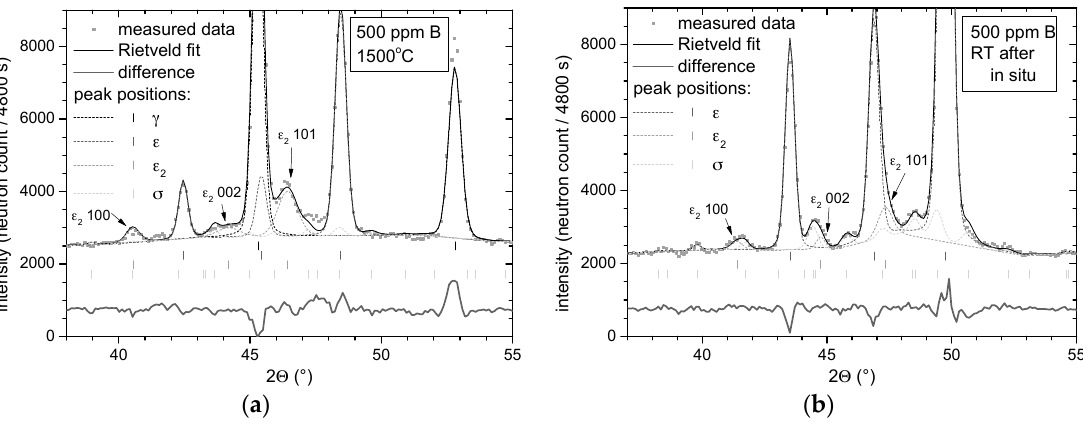
Figure 8. The section of the diffractograms ( a ) at 1500 °C and ( b ) at RT after the in-situ thermal cycle for 500 ppm B sample, showing the refinement in the important angular range. The arrows depict the positions of hcp-2 reflections 100, 002 and 101.